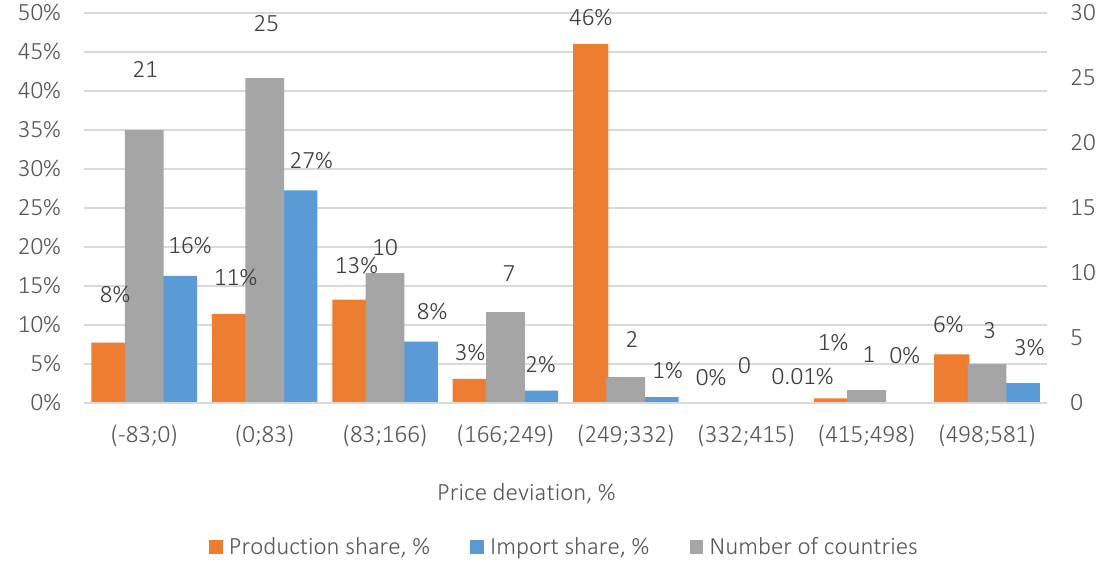
Figure 3. Histogram on deviations between production and import prices for apples Table 2. Inequality in the world apple market